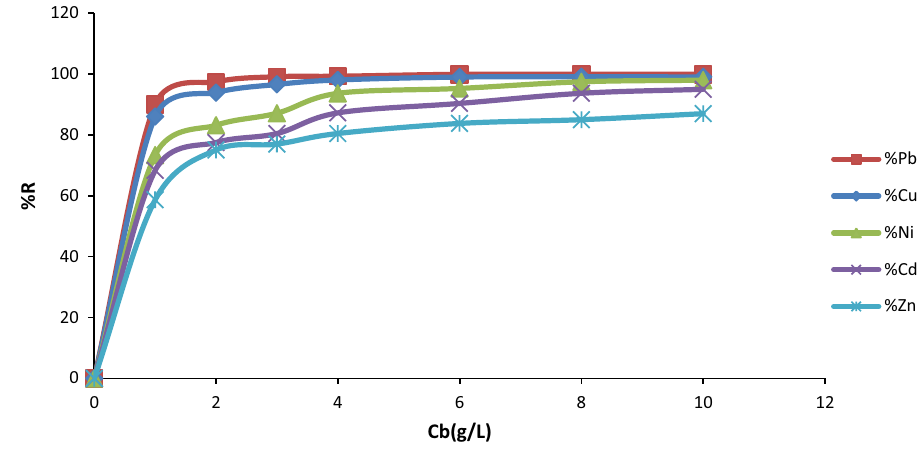
Fig. 4 Effect of sorbent dosage on the percentage removal of the metals M(II) by chitin